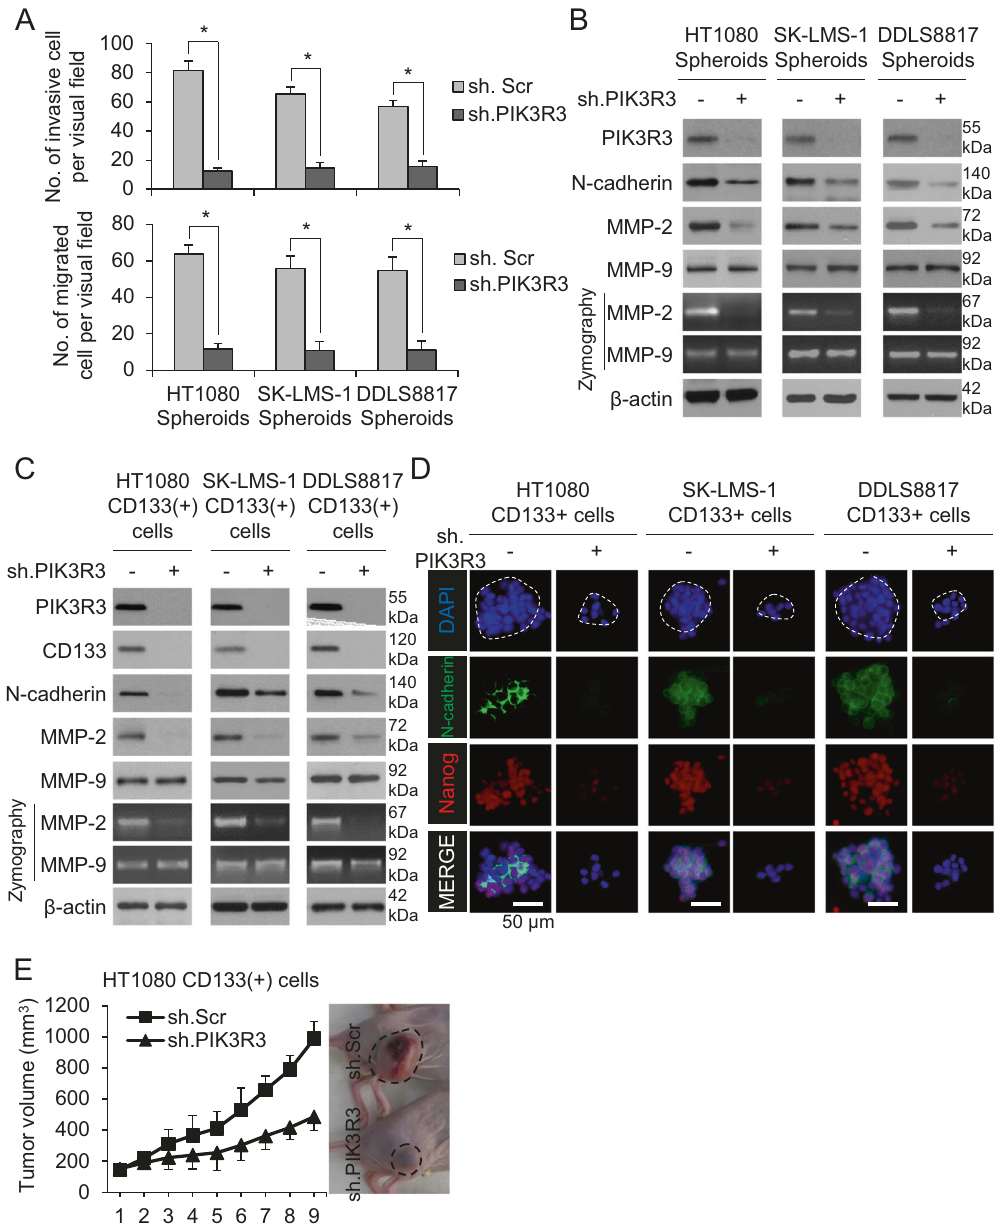
Fig. 3 PIK3R3 promotes migration and invasion in sarcoma CSCs. All panels compare sh.PIK3R3 vs. sh.Scr-transduced sarcoma cells. Invasion ( A ) and migration ( B ) assay for sarcoma spheroid cells. B Western blot and zymography for PIK3R3, N-cadherin, MMP-2, and MMP-9 in sarcoma spheroid cells. C Western blot and zymography for PIK3R3, N-cadherin, MMP-2, and MMP-9 in CD133 + cells. D Immunostaining for N-cadherin and Nanog, with DAPI counterstaining in CD133 + cells. E Tumor volume graph and representative photos of HT1080 CD133 + cells grown in athymic nude mice ( n = 5 mice in each